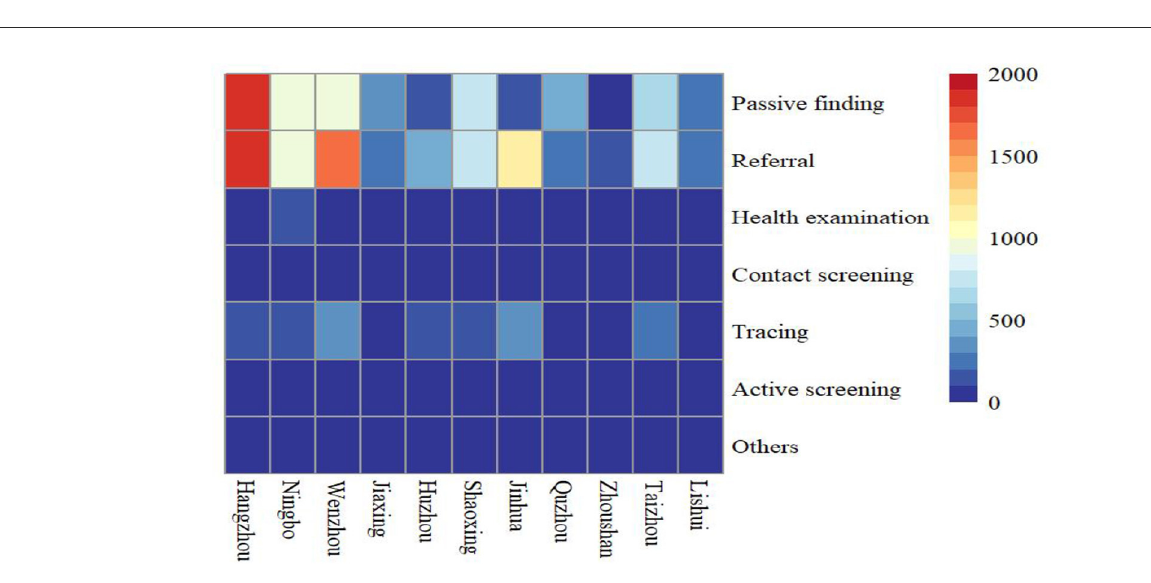
(95% CI, − 9.1 to − 1.1, P = 0.018) and 28.6% (95% CI, 2.1 to 62.0, P = 0.036), respectively (Table 2, Figure